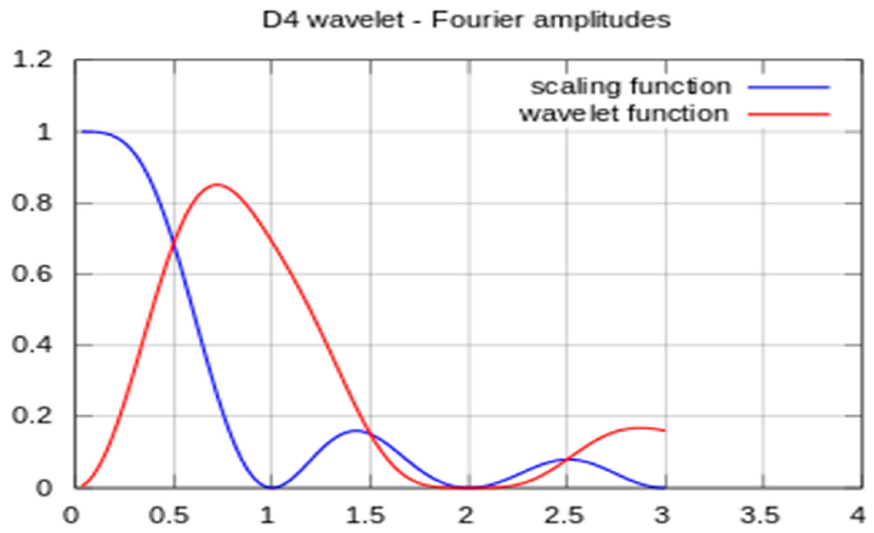
Figure 4. Amplitudes of the frequency spectra of the Daubechies wavelet and scaling functions.